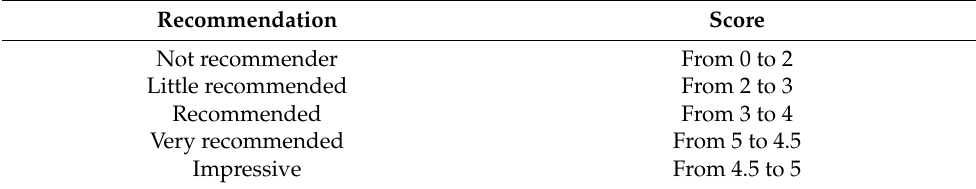
Table 1. Meaning of the